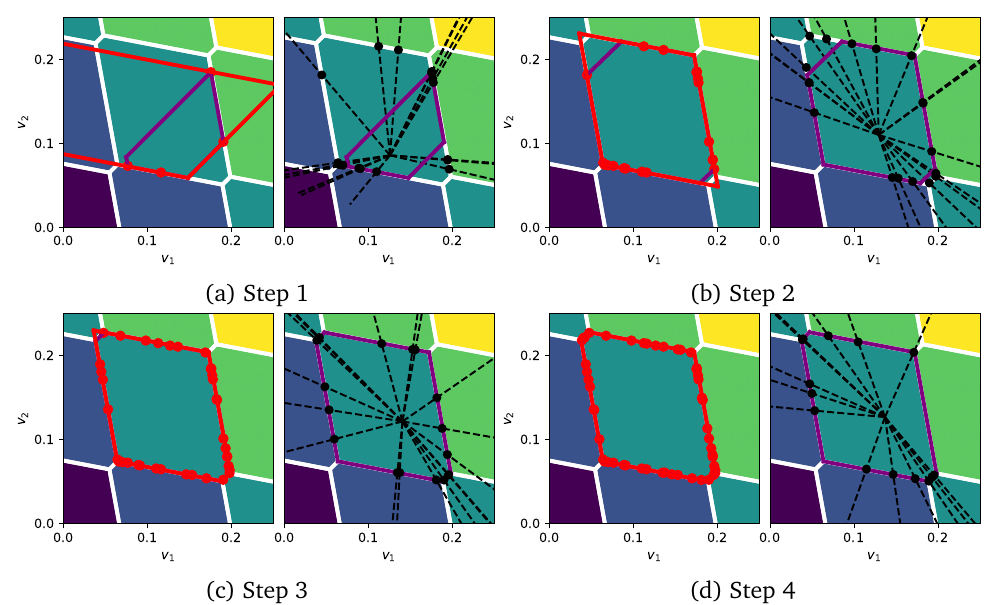
Figure 4: Visualization of a toy example of the algorithm for learning the polytope of the (1,1) state on a simulated double-dot device. Colored background with white lines represent the different states and boundaries of the device. Background colors are chosen based on the total number of electrons occupying the device in the state. a-d) Left: Model (red lines) fit to the measurements (red points, only v − are shown for ease of visualization). Purple lines: adapted model for sampling to account for facets that were not found during the fit. Right: Sampling process. for each facet of the adapted model three line-searches (dashed lines) are performed creating new pairs of datapoints (black